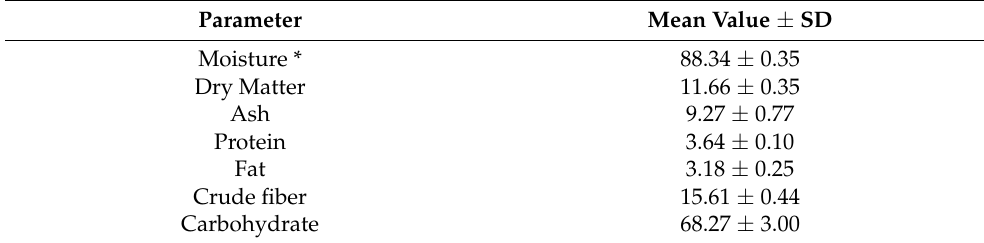
Table 3. Proximate composition of Ceiba aesculifolia subsp. parvifolia tuber pulp